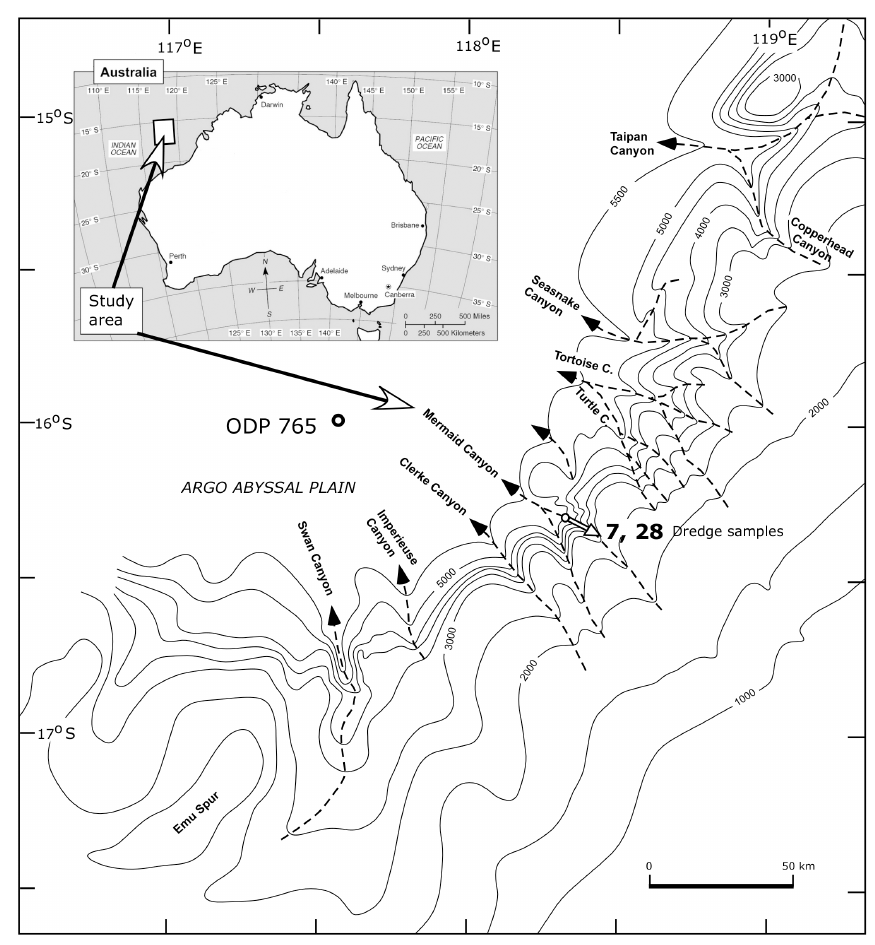
Figure 2. Locality of submarine dredge samples BMR 95/DR7/8 (7) and BMR 96/DR28/16 (28) (in the rifted Rowley sub-basin) and the approximate dredged distance in the Mermaid Canyon on the continental slope of northwestern Australia. Bathymetry in